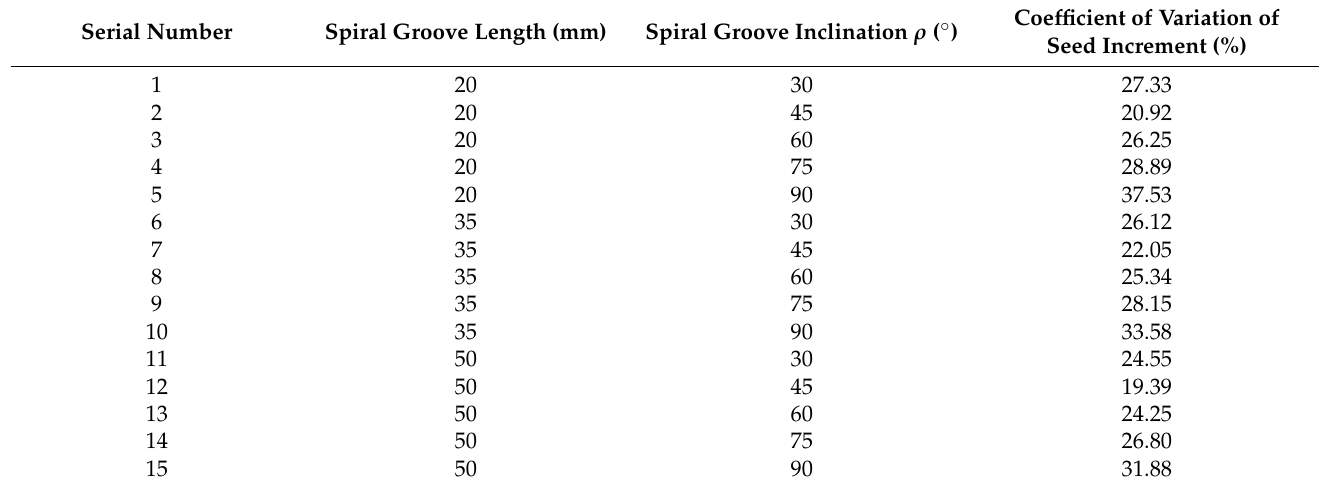
Table 3. Two-factor simulation test